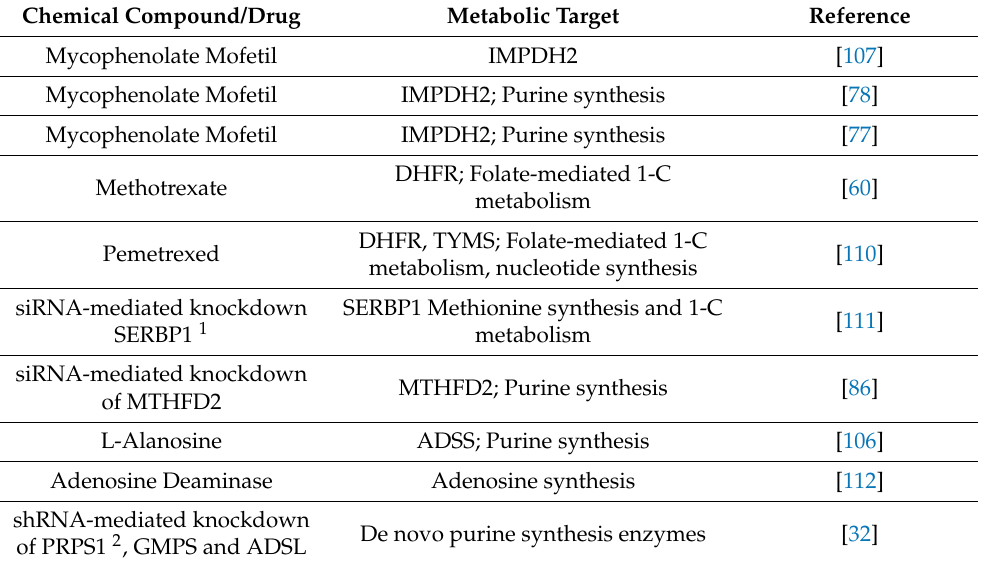
Table 2. Summary of recent studies targeting 1-C metabolism and purine synthesis-related metabolic pathways in